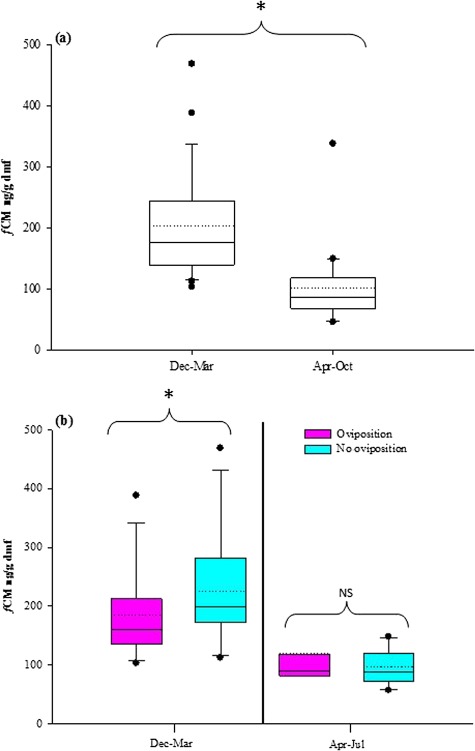
Concentrations of fCMs excreted between December–March and April–July of 2016–2017 from (a) captive Necturus beyeri breeding pairs (n = 6) and (b) pairwise comparison between breeding pairs whereby females went on to successfully oviposit eggs (n = 4) versus those that did not (n = 2). Box limits represent the 25th and 75th percentiles. Horizontal lines through the box represent the median values, dotted lines the mean value and outliers as black circles. Significance level between groups is indicated by * (P < 0.05), while non-significance (P > 0.05) is indicated by NS